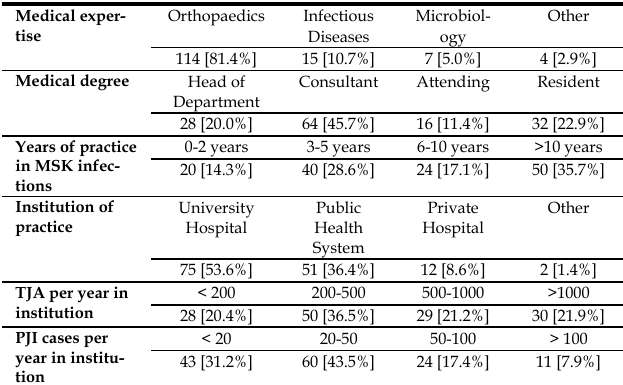
Table 1. Personal and Institutional information.